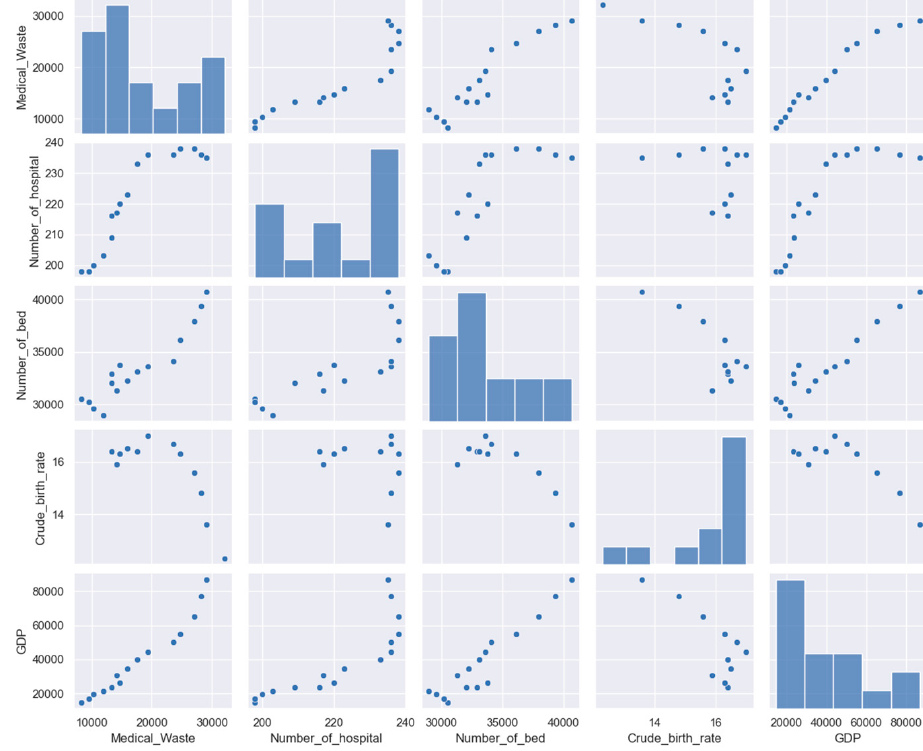
Figure 4. Pair plots for input and output variables.